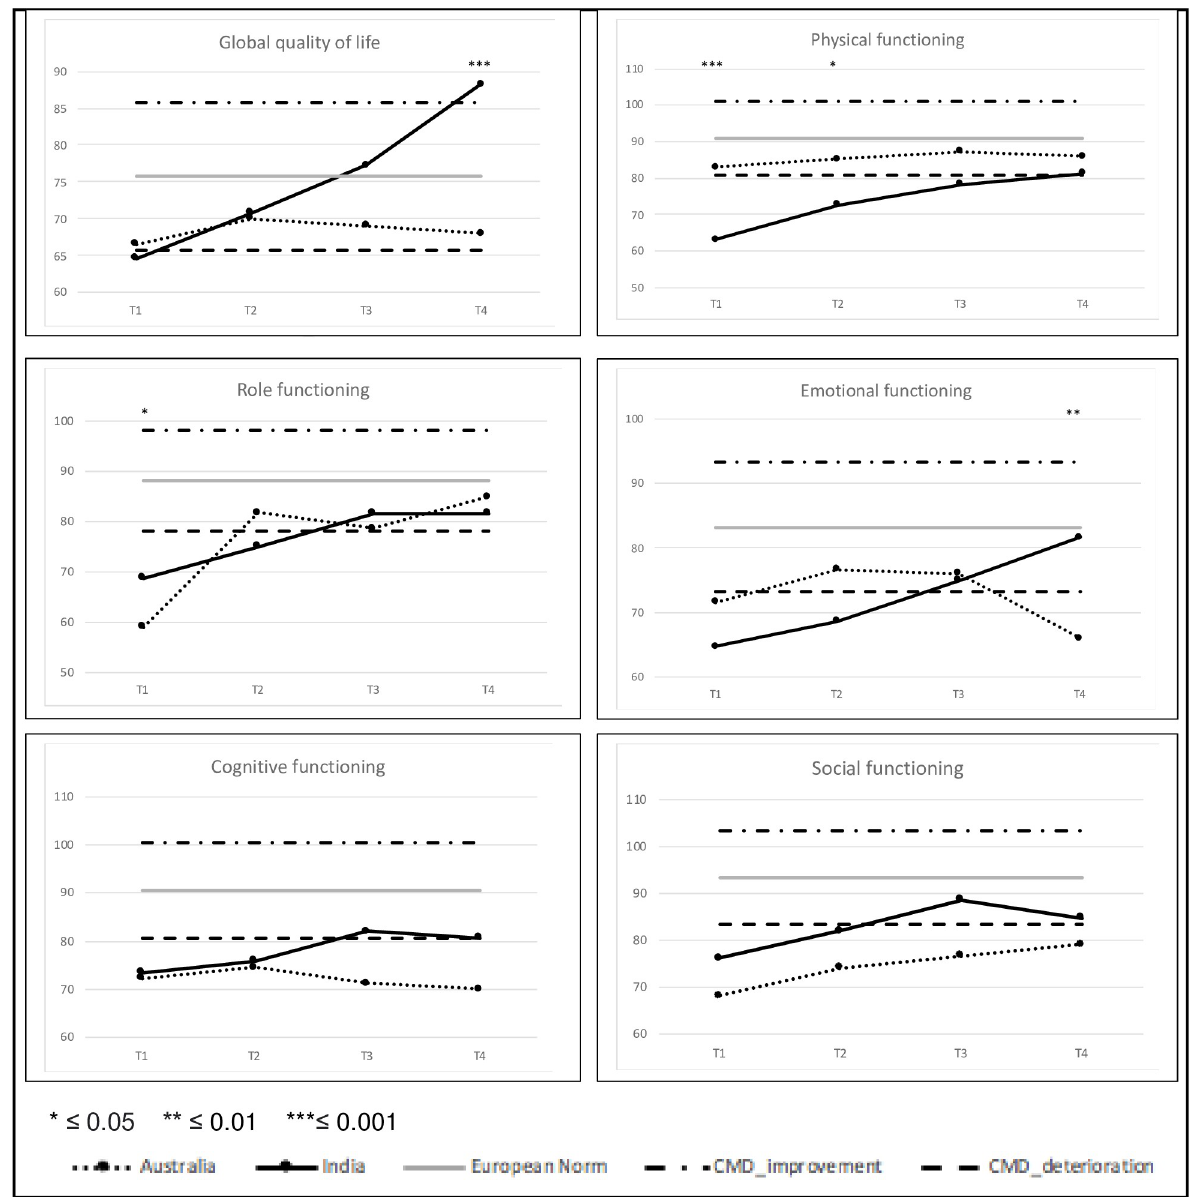
Fig 1. QLQ-C30 function scales and clinically meaningful difference (CMD) to the European normative